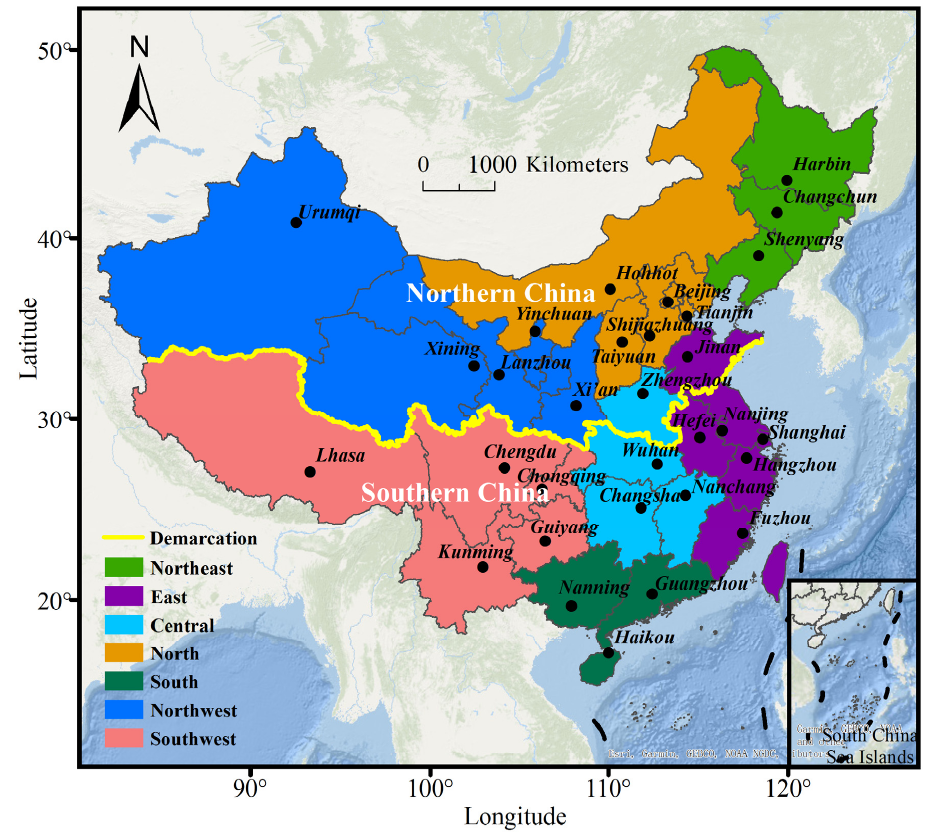
Figure 1. Map of China. (Northern and southern China are divided by the yellow Updated Figure 1. . (add graphic example)